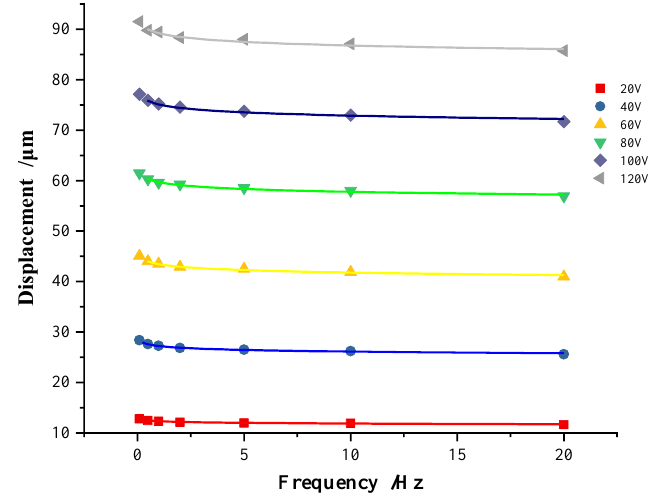
Figure 6. Relationship between peak displacement and driving voltage frequency. For the discrete points of the peak displacement value under six groups of voltage amplitude, the parameters are determined by Equation (1) as shown in Table 1.